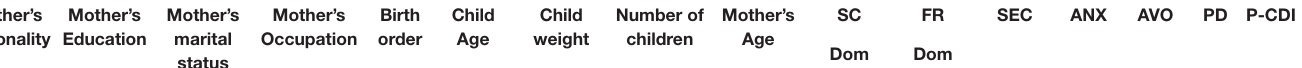
TABLE 3 | Correlation